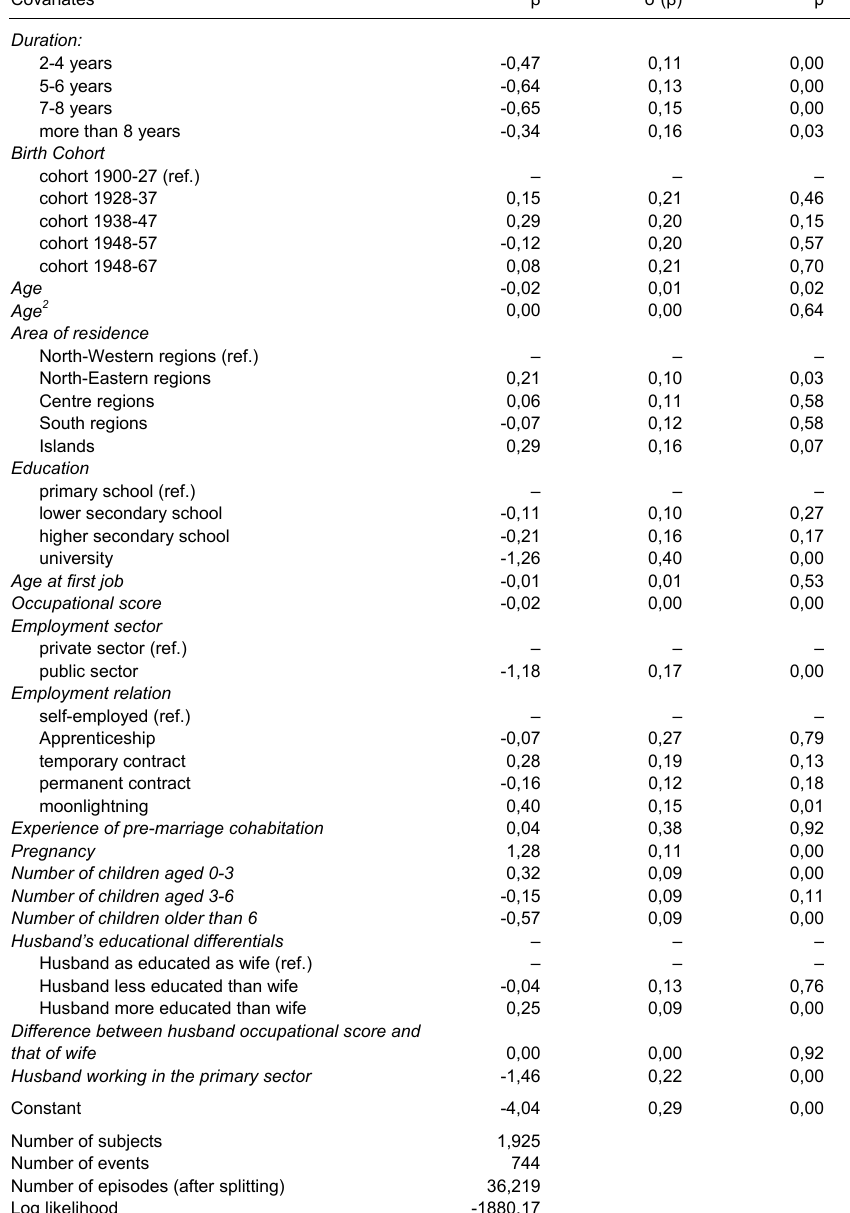
Table 5 Transition from employment to housework among Italian wives. Piece-wise constant exponential model. Covariates β σ ( β )